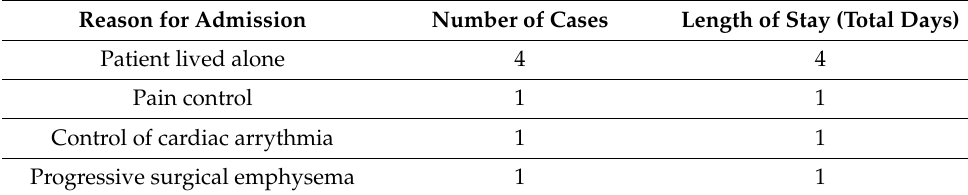
Table 2. Reasons for admission post thoracoscopy and length of stay